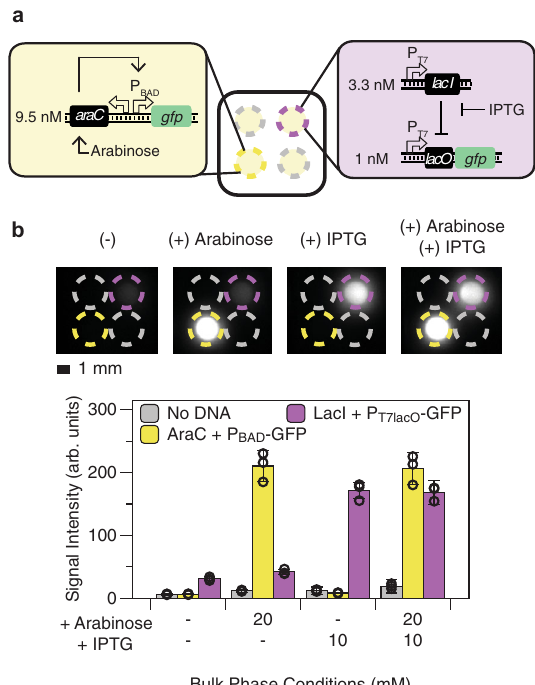
Fig. 3 Simultaneous detection of multiple model small molecules in membrane-less protocell arrays. a Schematic of protocell array setup for simultaneous detection of two small molecules. Yellow and purple circles indicate micro-basins containing arabinose and IPTG sensors, respectively. Gray circles are micro-basins containing CFE protocells without plasmids. The circuit diagrams and plasmid concentrations used for the arabinose and IPTG sensors are shown in the insets. b Representative fl uorescence images and their quanti fi cation results after 3 h of incubation at 37 °C. Small molecules added to the bulk phase for each experiment are indicated above each image. Circle colors are as in a . Each protocell sensor is only activated when its cognate small molecule (10 mM IPTG, 20 mM arabinose, or both) is present in the bulk phase. Data are presented as mean values ± SD of 9 replicates (3 biological replicates × 3 technical replicates) for protocell sensors and 18 replicates for controls with no plasmid (3 biological replicates × 6 technical replicates). Hollow circles represent the mean of each biological triplicate. Scale bar is 1 mm. Data on each biological triplicate are provided in Supplementary Fig. 3. Details of CFE lysate used and plasmid sensor concentrations are provided in Supplementary Table